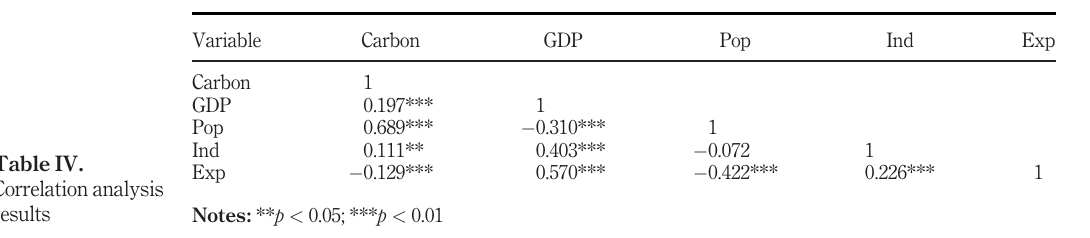
Table III. Details of the climate